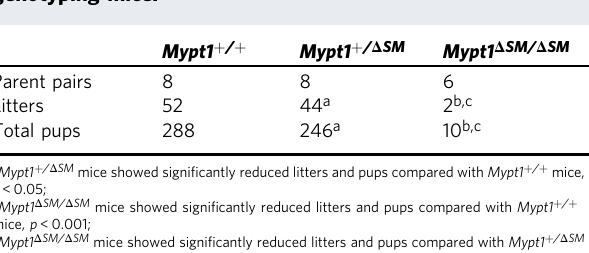
Table 1 Characterization of the birth patterns of different genotyping mice.